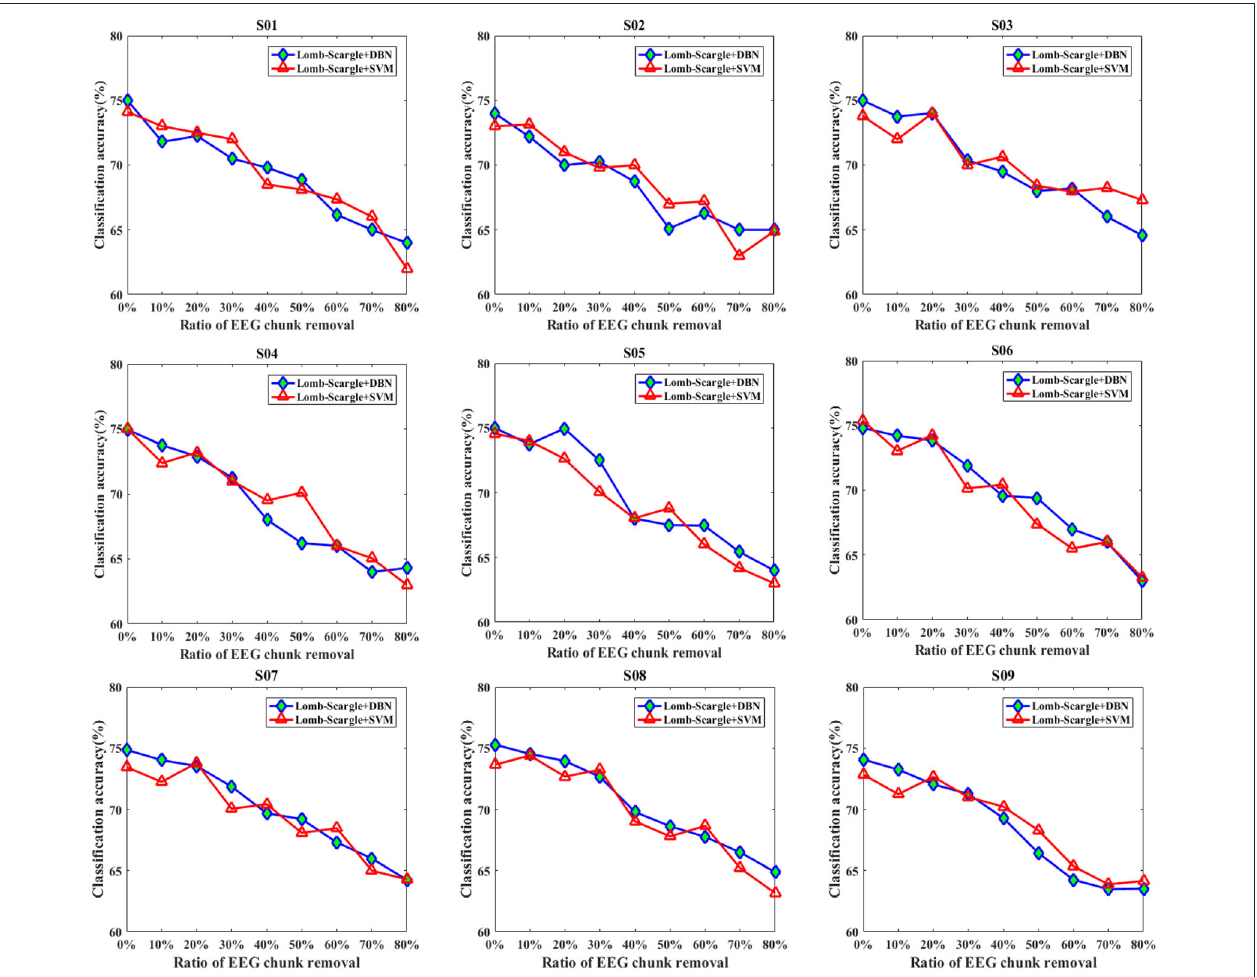
FIGURE 8 | The comparative performances between DBN and SVM classifiers for the intact EEG and incomplete EEG with various ratios of data chunk removal (from 10 to 80% with a step of 10%), for the nine subjects (from S01 to